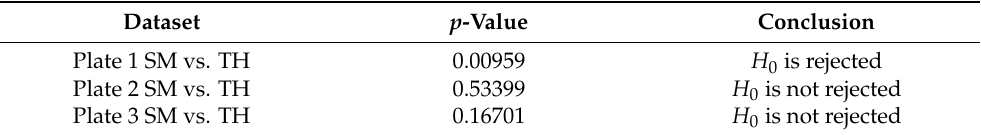
Table 11. Results for the Mann–Whitney